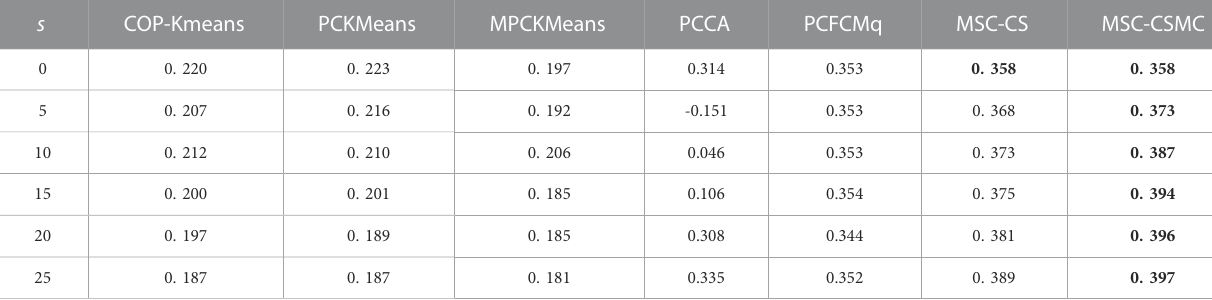
The bold values indicate the optimal solutions in each row.